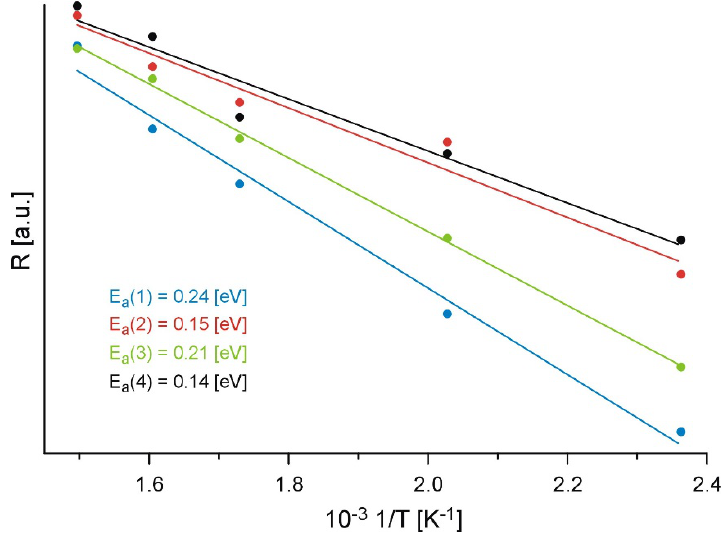
Figure 2. Arrhenius plots based on the data from four analyzed crystallites.